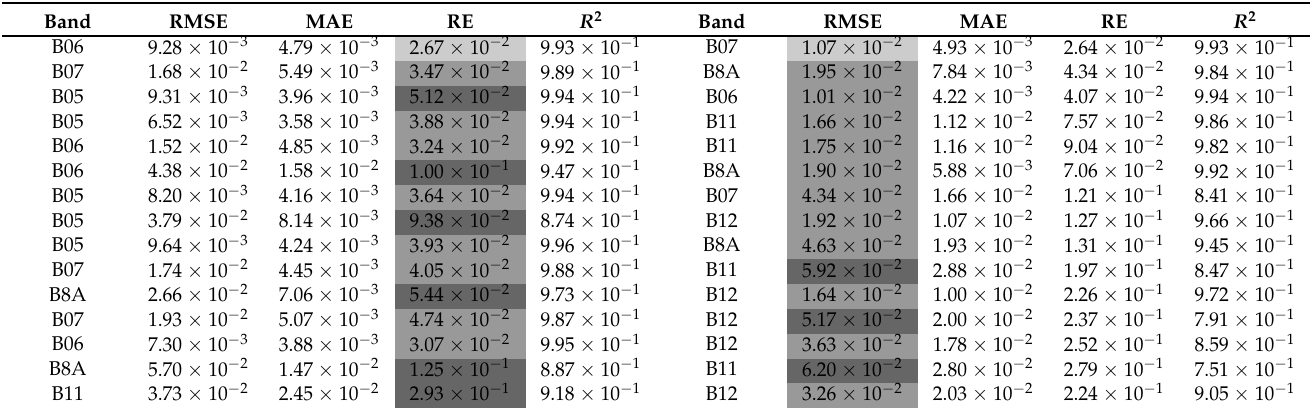
Table 15. Double-band regression results for L1C. The colors in the RE (relative error) columns indicate whether the specification is fulfilled (light gray), nearly fulfilled (middle gray) or unfulfilled (dark gray).